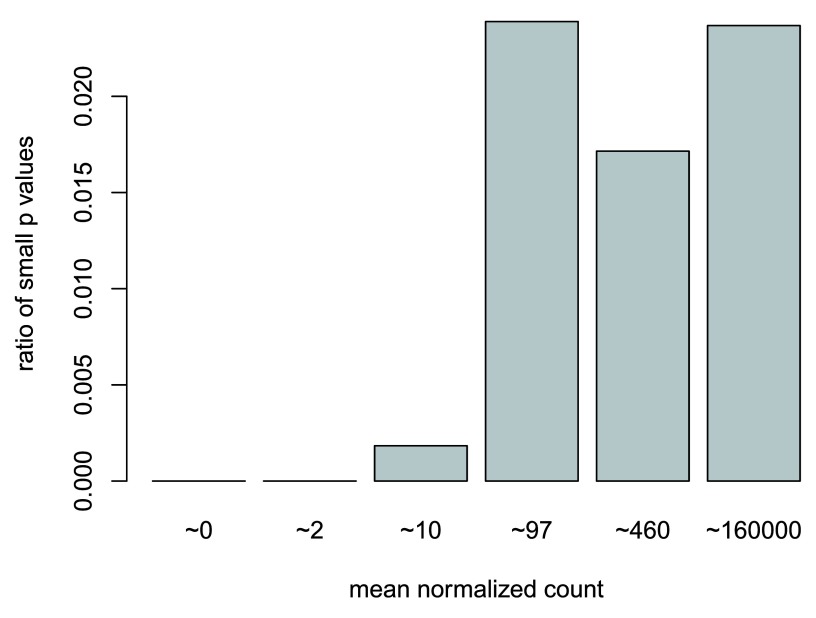
The ratio of small
p values for genes binned by mean normalized count.Here the
p values are for a test of log2 fold change greater than 1 or less than -1. This plot demonstrates that genes with low mean count are underpowered, and best excluded before multiple test correction.